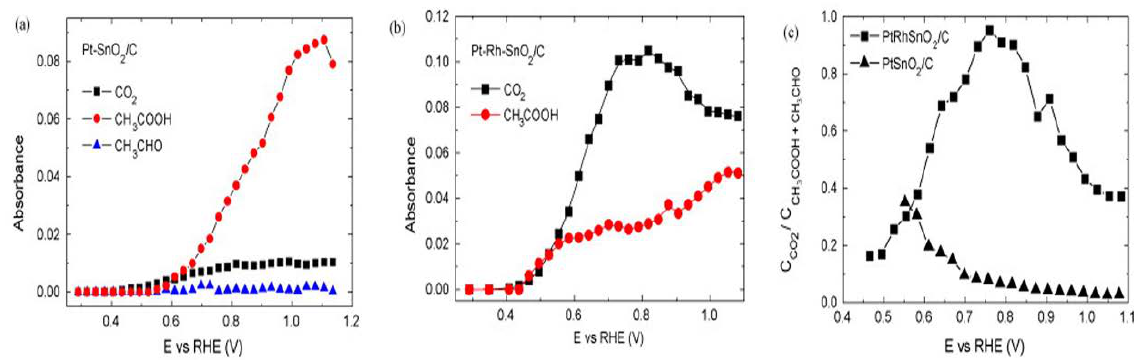
Figure 9. Integrated band intensities of CO 2 , CH 3 CHO and CH 3 COOH in IRRAS spectra from ( a ). Pt–SnO 2 /C with the atomic ratio Pt:Sn = 3:4; ( b ). Pt–Rh–SnO 2 /C with the atomic ratio Pt:Rh:Sn = 3:1:4; ( c ) The charge ratio of the total oxidation pathway ( C CO ) over the 2 partial oxidation pathway ( C CH + C CH ) as a function of electrode potential for both 3 COOH 3 CHO electrocatalysts in 0.1 M HClO 4 and 0.1 M ethanol. Reprinted and adapted with permission from Reference [9]. Copyright 2010,